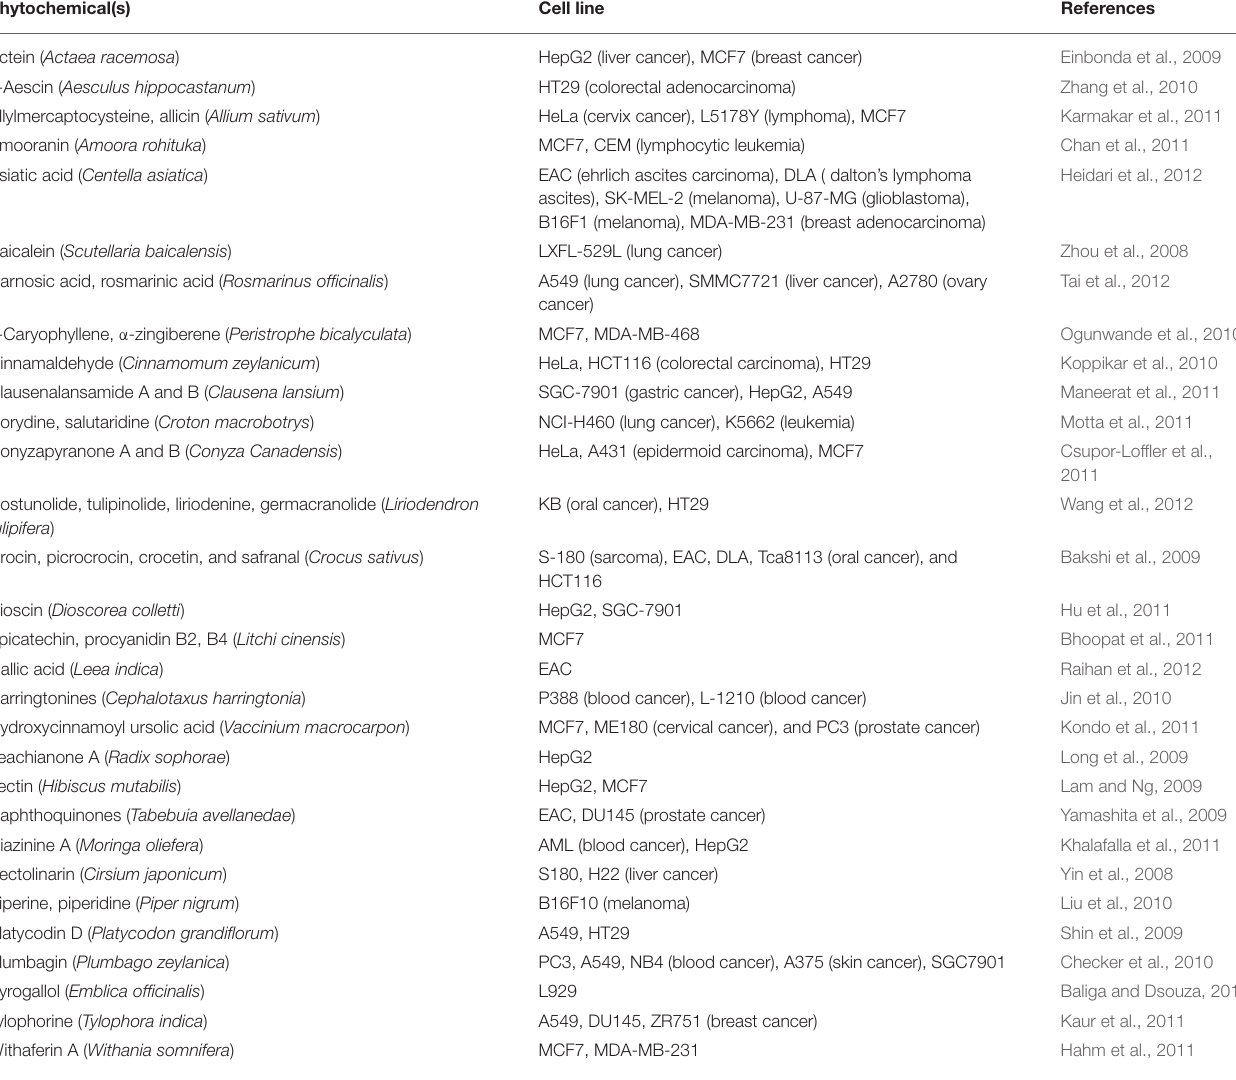
TABLE 4 | Phytochemicals which are cytotoxic against cancer cell